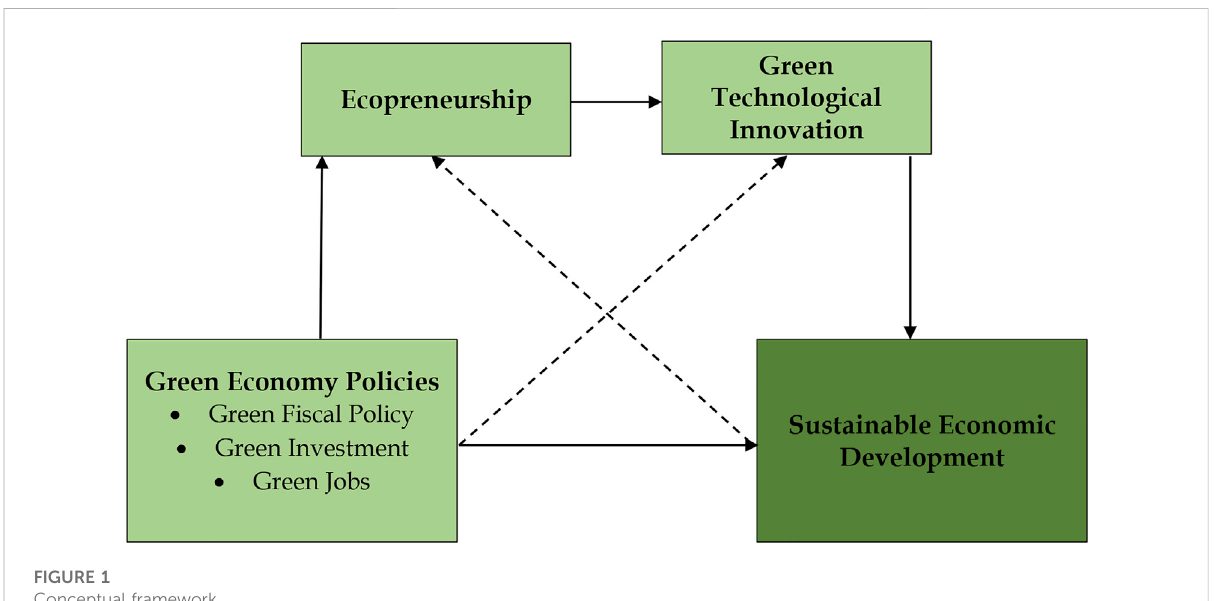
FIGURE 1 Conceptual